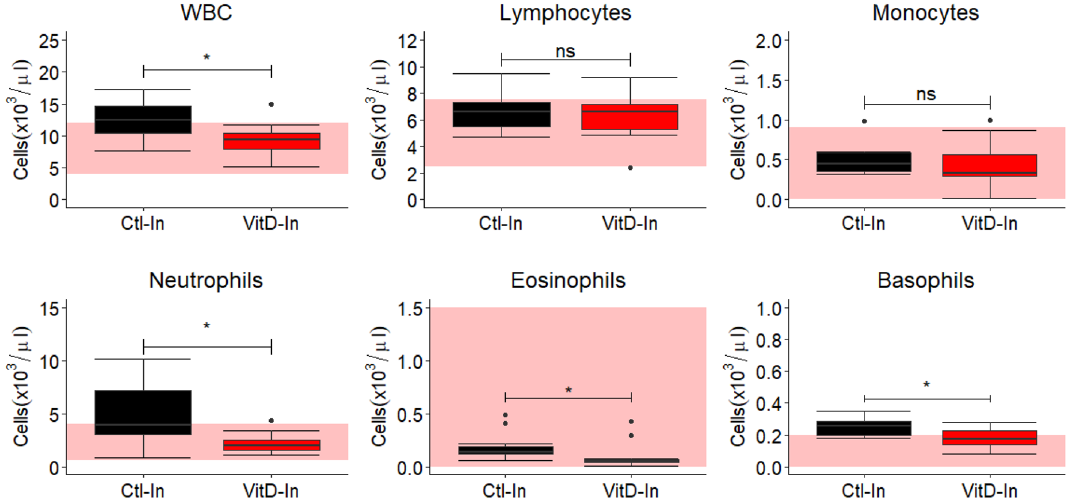
Figure 4. Collective differences in the cell profile between indoor groups at T6. Data shows the boxplot of WBC (white blood cells), neutrophils, eosinophils, basophils, lymphocytes, and monocytes of Ctl-In (n = 11) and VitD-In (n = 12) groups at T6 . Collective differences between groups were analysed by MANOVA as described in material and methods section. Pink area shows references values according to Merck Veterinary Manual. Dots represent outlier values. * p < 0.05, ns not significant.